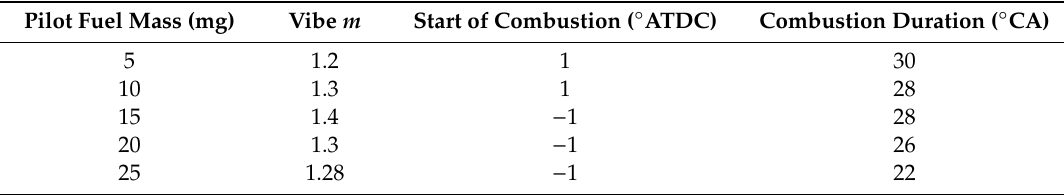
Table 4. Vibe coe ffi cient m and combustion